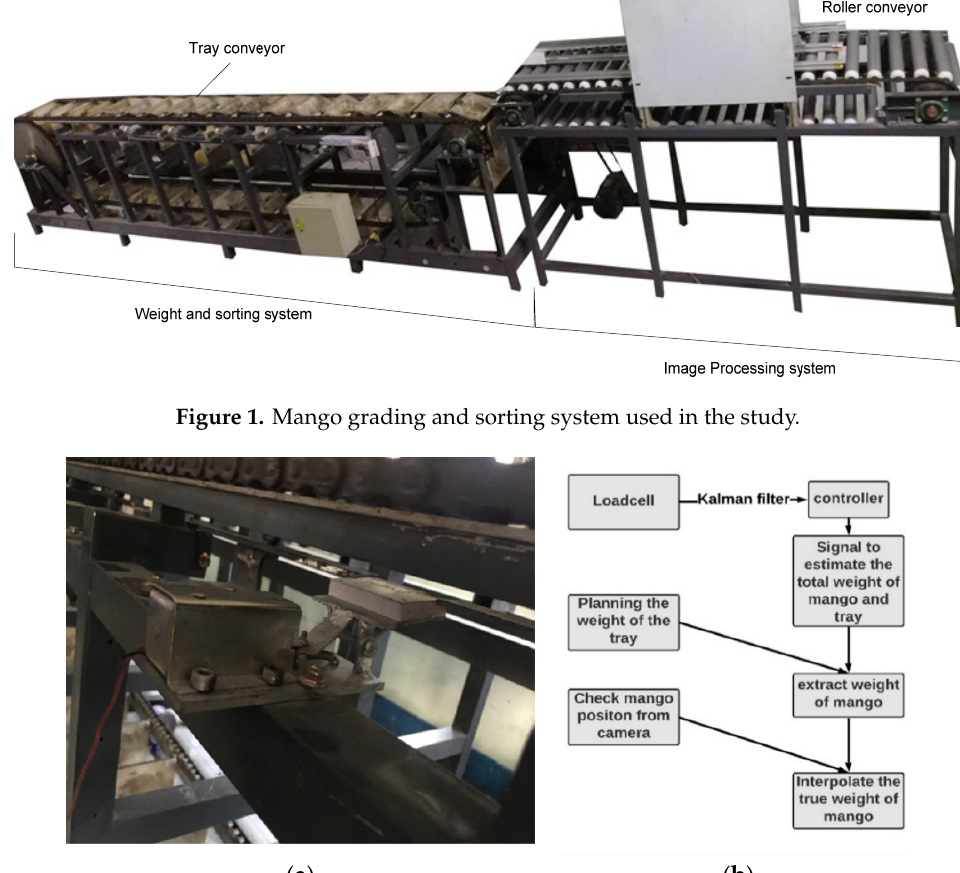
Figure 1. Mango grading and sorting system used in the study.